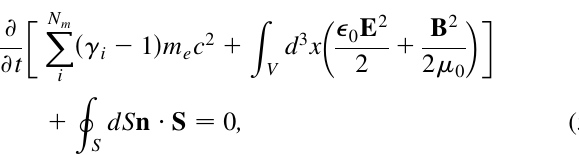
(cid:1) 0 , radius a (cid:1) a (cid:1) a (cid:1) 0 1 2 3 (cid:1) 0 , average max ’ 1 : 74 (cid:4) m , and cutoff 0